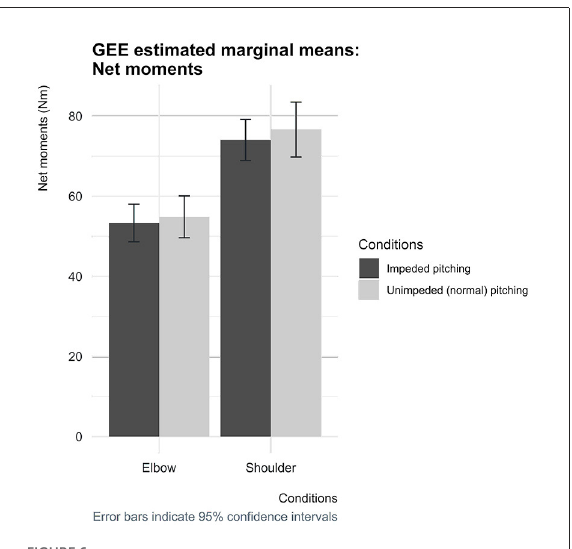
FIGURE6 Estimated marginal means for the peak net moments at the shoulder and elbow for both conditions with corresponding 95% confidence interval error